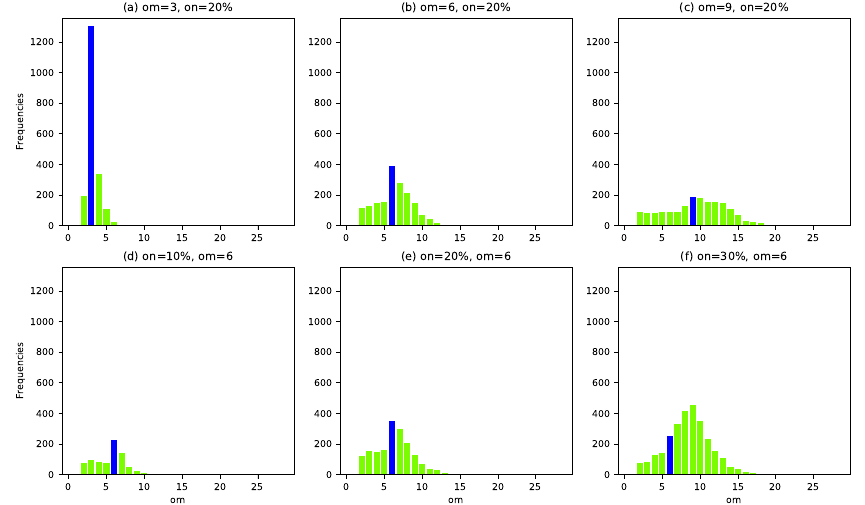
Figure 2. Distributions of amended overlapping memberships of LFR synthesized